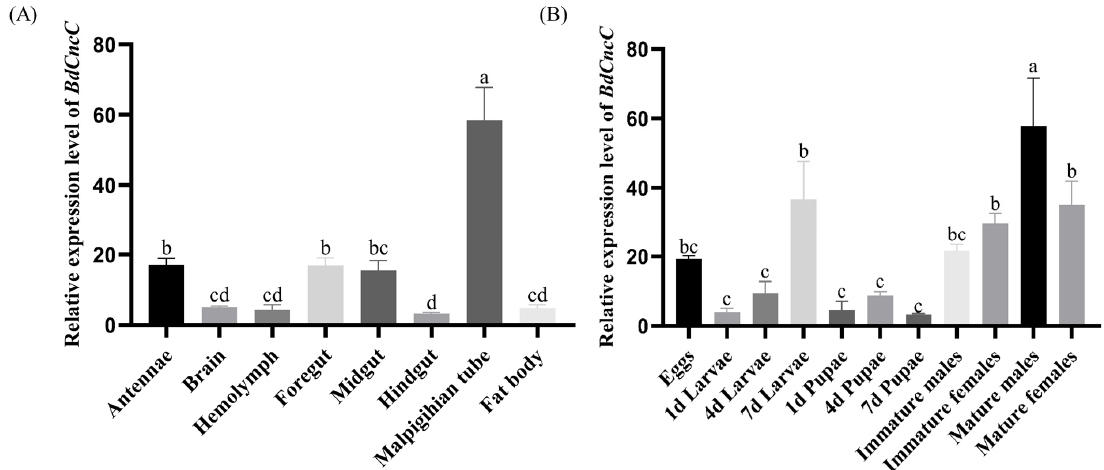
Figure 4. Expression profiles of the BdCncC gene in different tissues and developmental stages of B. dorsalis . ( A ) Expression profiles of the BdCncC gene in different tissues, and different colors indicate different tissue; ( B ) Expression profiles of the BdCncC gene in different developmental stages, and different colors indicate different developmental stages. Means and SEs from five biological replicates are shown. The different letters above the bars indicate significant differences in gene expression levels among treatments ( p < 0.001, one-way ANOVA test).